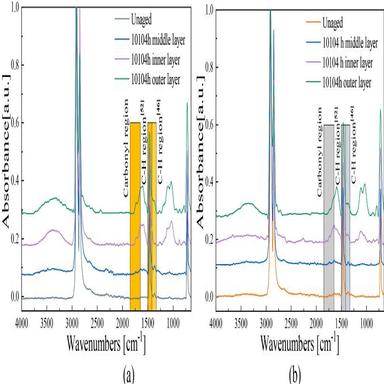
FTIR spectrums of PE80 (a) and PE100 (b) in different position.